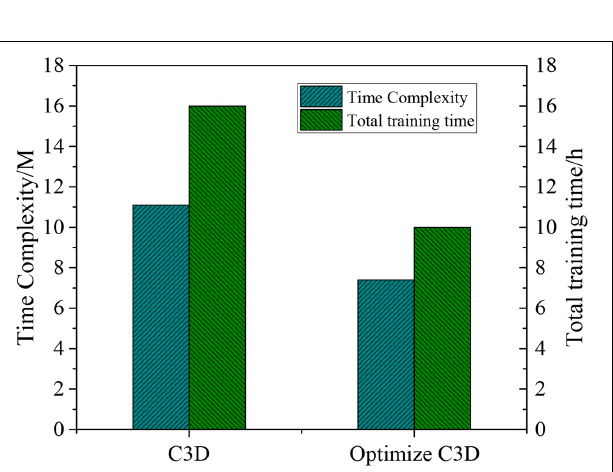
FIGURE 6 | Comparison of time complexity between C3D and optimised